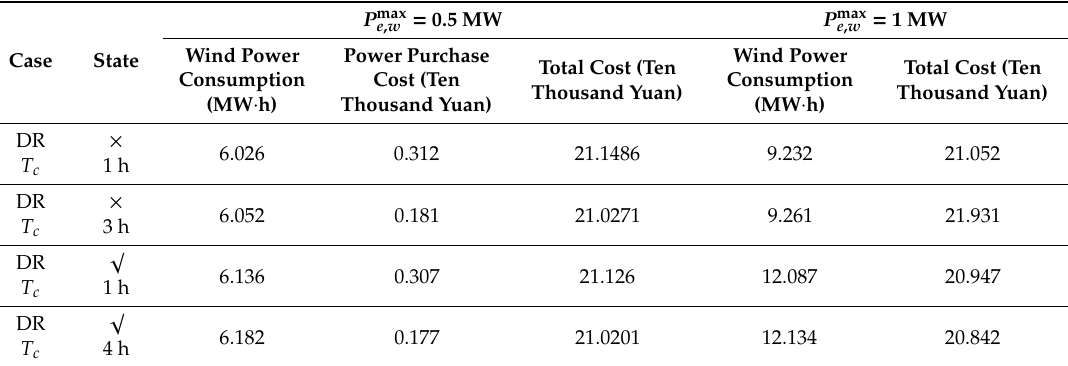
Table 3. Economic cost comparison.